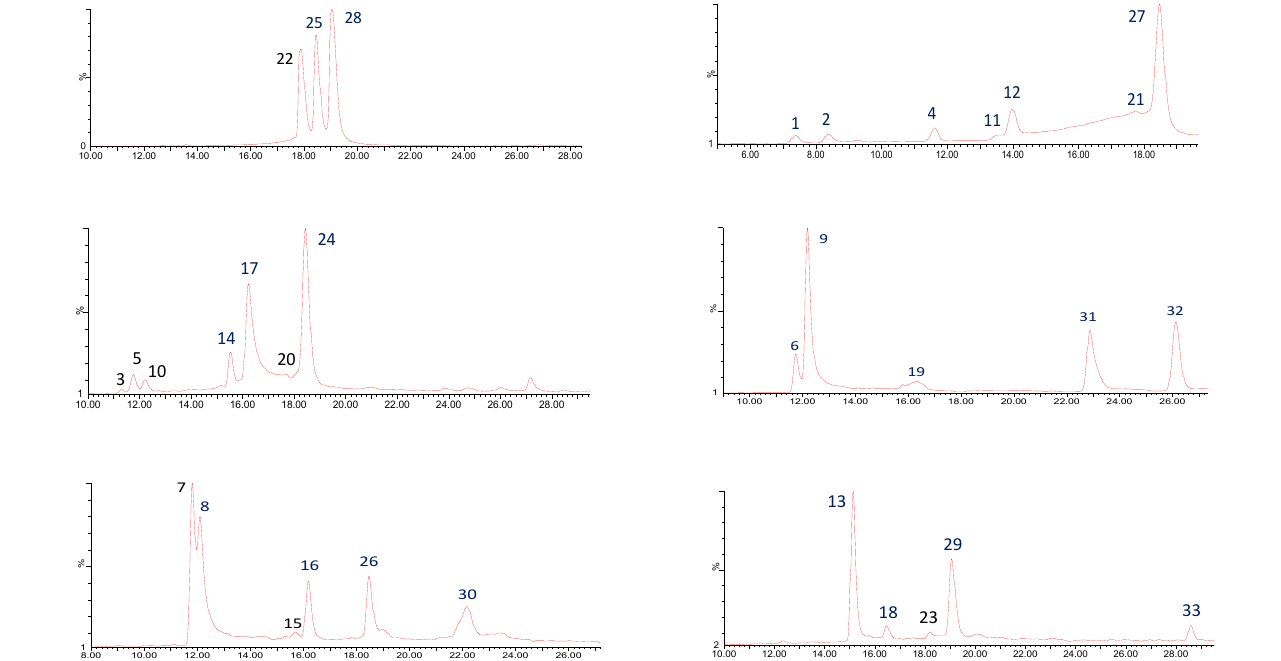
Figure 1. UHPLC QTOF-ESI MS extracted ion chromatograms of curcuminoids from C. longa rhi- zomes, in a Phenomenex Luna RP18 C-18 column (150 mm × 4.6 mm × 4 µ m) using a Xevo G2-XS QTOF Mass spectrometer (Waters™, Wilmslow, UK) in a mass range from 100 to 1000 Table 2. Profile of the phenolic compounds identified by UPLC-QTOF-ESI MS in Curcuma longa rhizomes from Costa Rica.